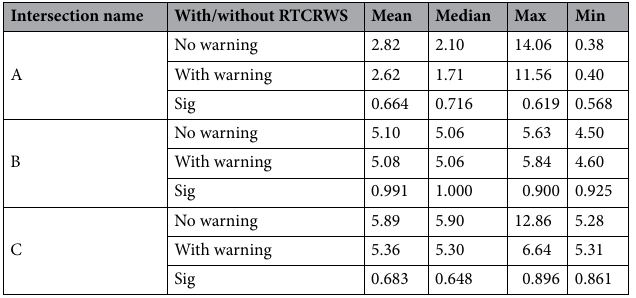
Table 3. Comparison of the characteristic values of skin electricity. Sig . significance level of T-test.